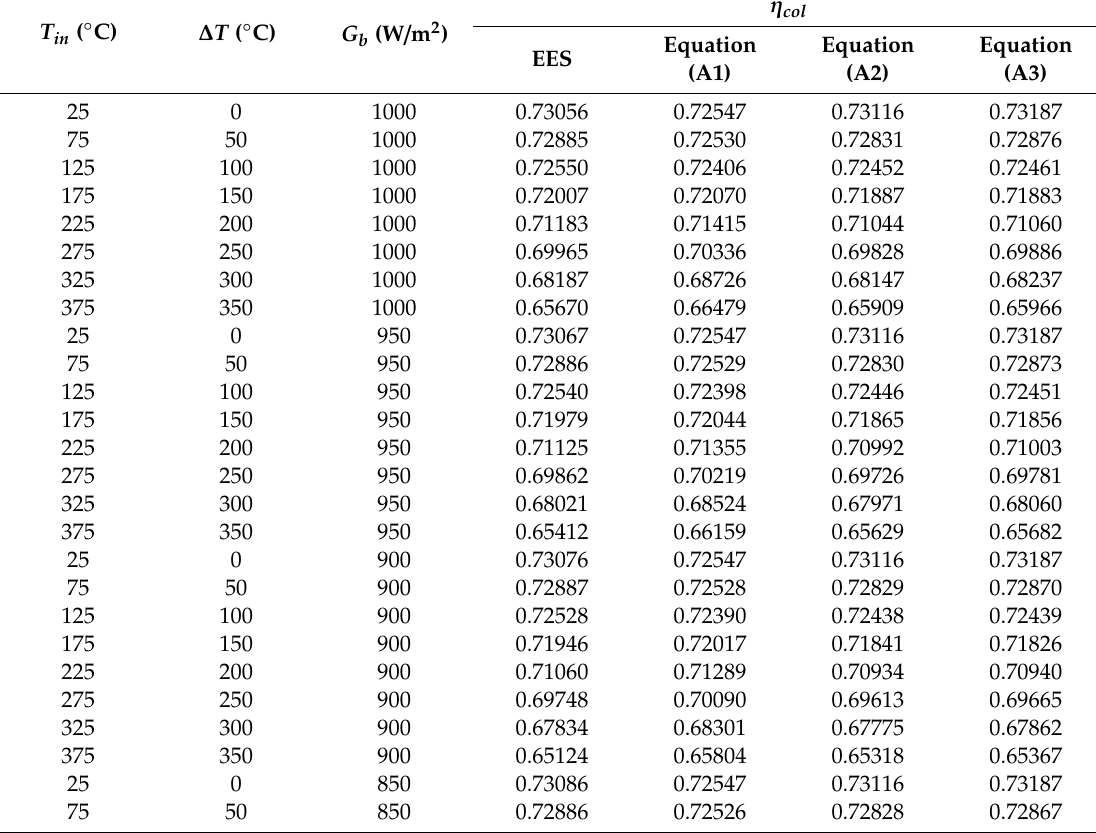
Table A1. Dataset for the approximation